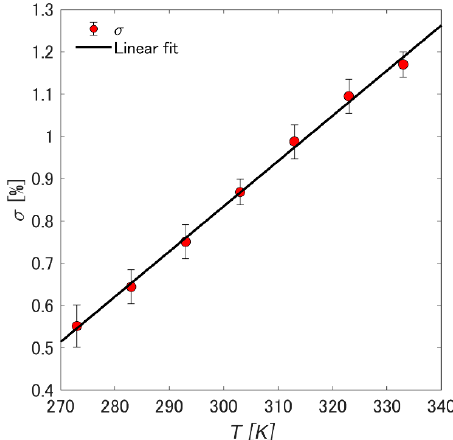
Figure 9. Pressure sensitivity, σ , with varying the measurement temperature, T , under the uncontrollable reference temperature T ref,unc = 303 K.